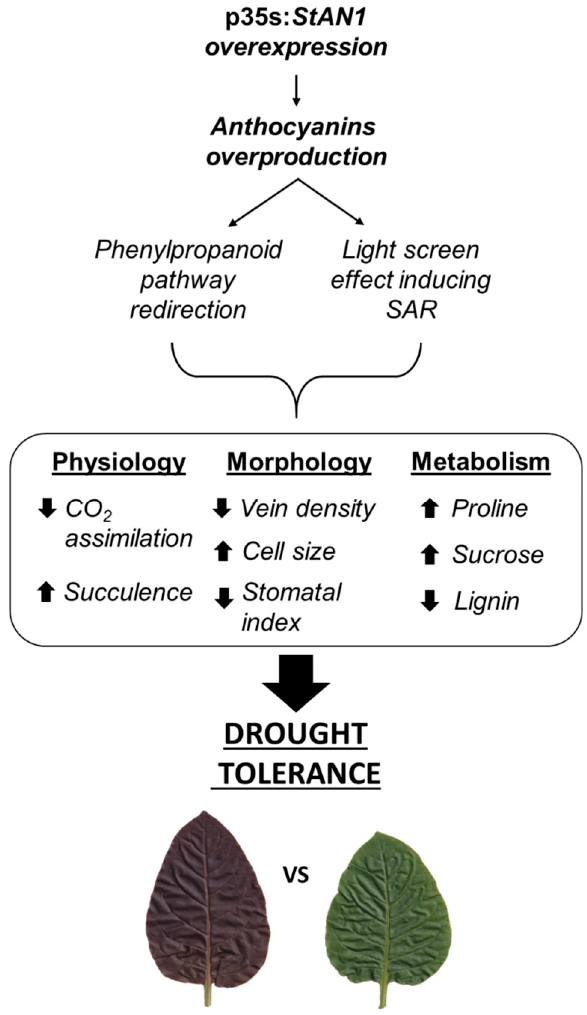
Figure 10. Schematic representation of the possible consequences of anthocyanin accumulation in tobacco leaves. The overexpression of StAN1 induces anthocyanin overproduction, which leads to a redirection of the phenylpropanoid pathway and/or a light screening effect mediated by anthocyanins. These events cause a full reshape of plant physiological, morphological and metabolic parameters, making StAN1 overexpressing plants more tolerant to drought stress.